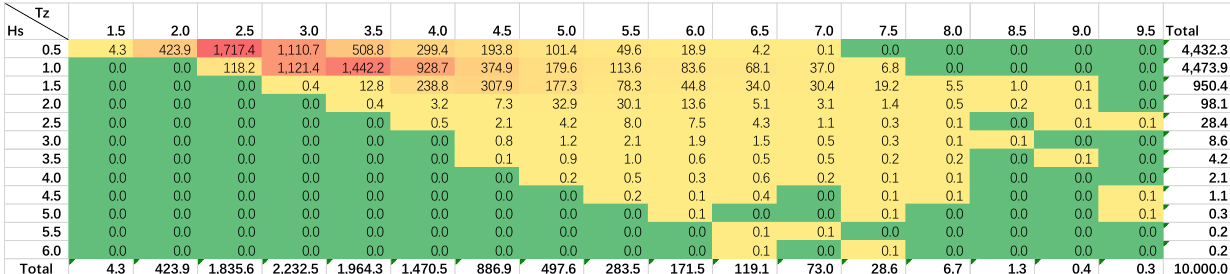
Figure 18. Wave scatter diagram at Site E.